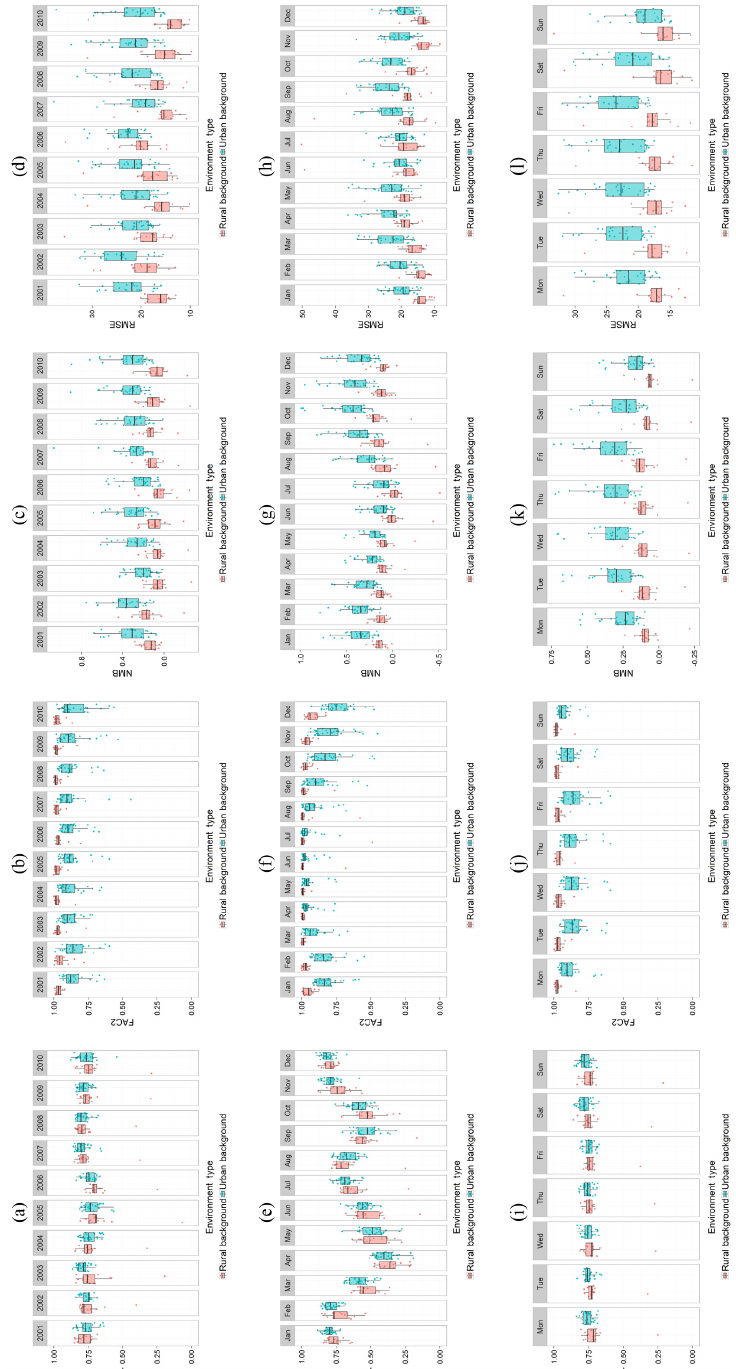
Figure 3. Model–measurement statistics per site for O 3 daily maximum 8h mean concentrations during 2001–2010, by site type, and by (a– d) year, (e–h) month-of-year, and (i–l) day-of-week. (a) , (e) , and (i) are Pearson’s correlation coefficient ( r) ; (b) , (f) , and (j) are the fraction of data pairs within a factor of 2 (FAC2); (c) , (g) , and (k) are normalized mean bias (NMB); and (d) , (h) , and (l) are the root mean squared error (RMSE) in µgm − 3 . Dots show individual site statistics ( n = 17 and 30 for RB and UB sites, respectively), which are summarized in the superimposed box plot whose shading demarcates the interquartile range (IQR) and whose whiskers extend to the largest and smallest values within 1.58 × IQR from the box